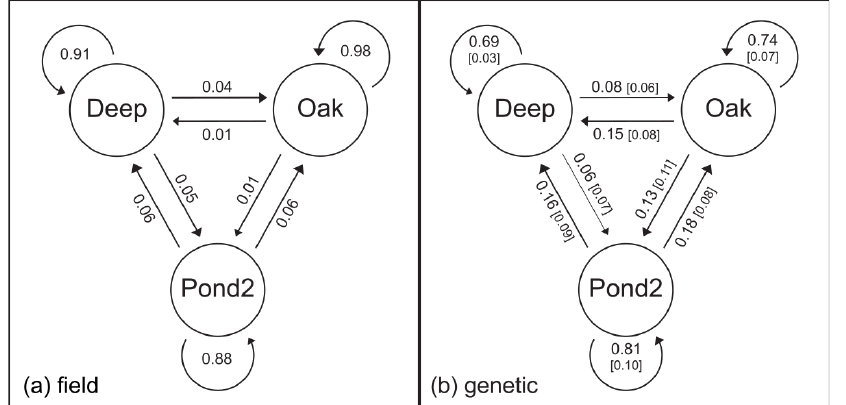
Figure 1. Estimates of population connectivity for Ambystoma opacum in the Maple Flats Sinkhole Complex, VA, USA. ( a ) Capture-mark-recapture migration estimates, measured as movement probabilities, averaged over a four-year study. Standard errors are in brackets. ( b ) Means of the posterior distributions of m, the average recent gene flow represented as proportion of migrants, calculated in the program BAYESASS. Standard deviations are in brackets.